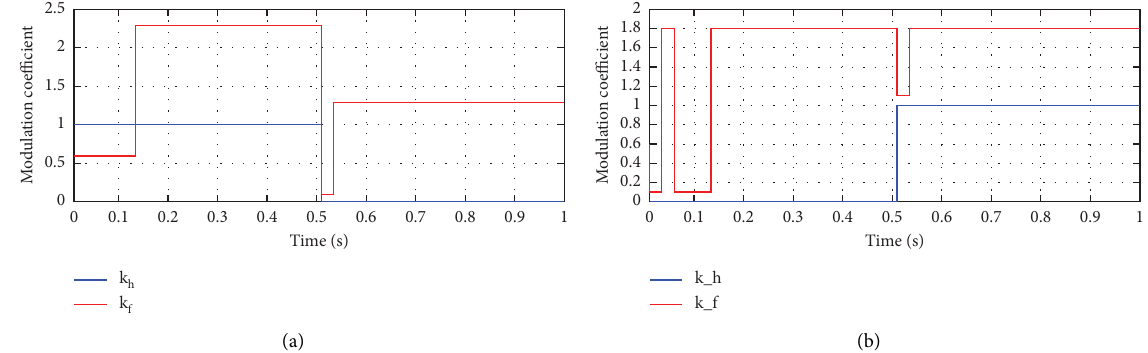
Figure 12: Modulation coefcients of reference currents of grid-connected inverter of PV system (a) and wind generator (b).